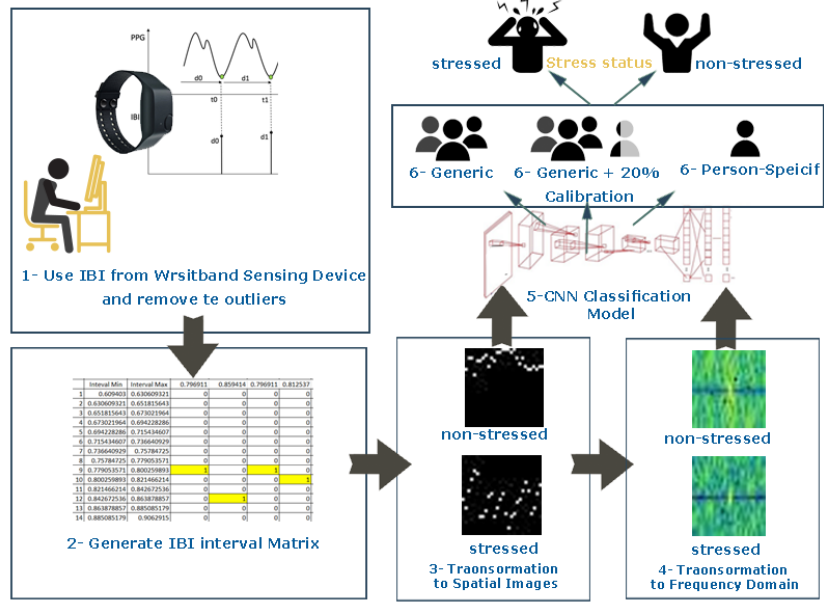
Figure 1. Proposed stress classification models